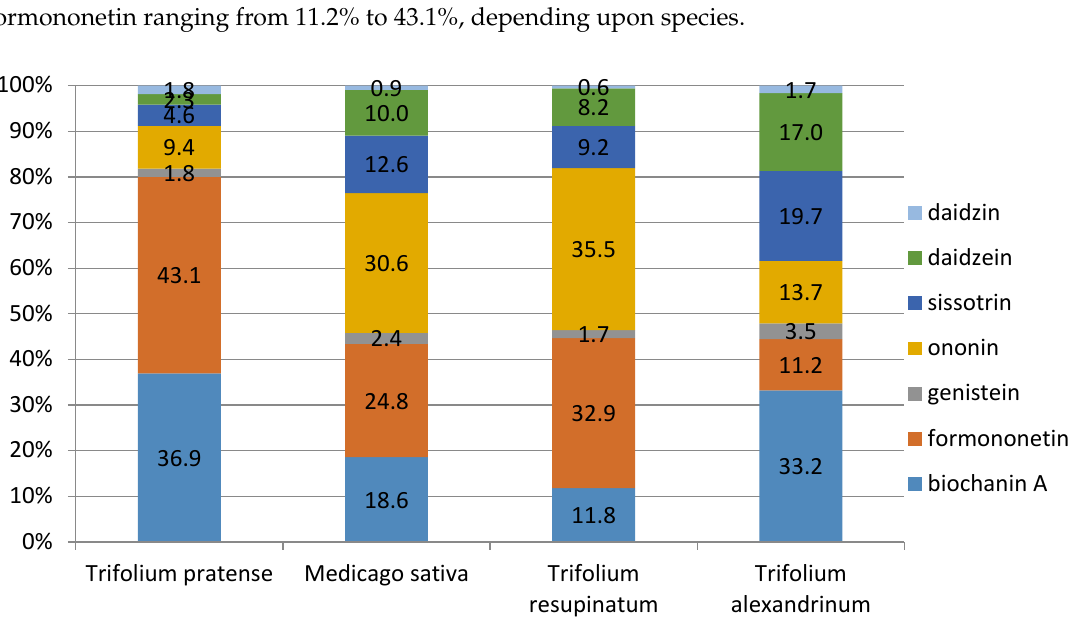
Figure 8. Percentages of isoflavones determined in Trifolium pratense , Medicago sativa , Trifolium resupinatum , and Trifolium alexandrinum .